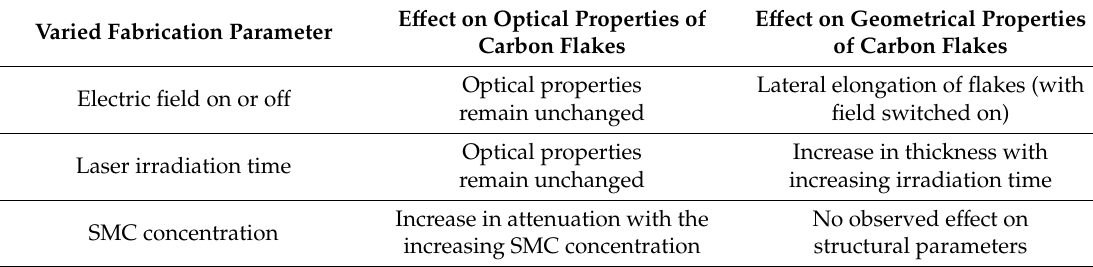
Table 2. Variable fabrication parameters and their e ff ect on carbon